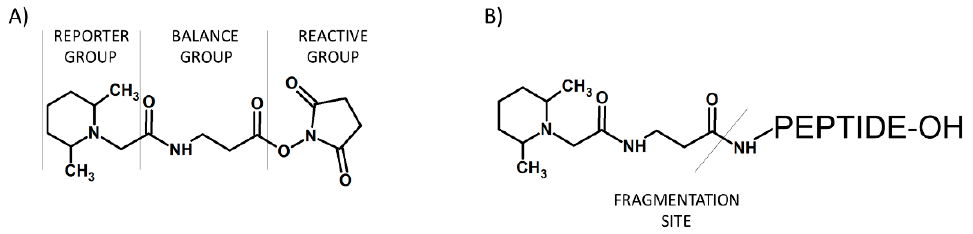
Figure 5. The structure of commercially available TMT ( A ) and the peptide modified by tandem mass tag ( B ) [17].